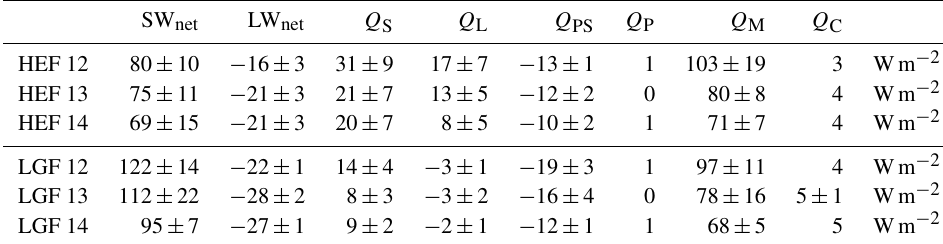
Table 4. The energy balance components are averaged over all stake locations. The uncertainty is given in respect to the minimum and maximum of the ensemble. The short-wave radiation (SW net ) has the largest impact, decreasing in importance from 2012 to 2014, with a less negative mass balance ( Q M ). The penetrating short-wave radiation ( Q PS ) follows the same pattern with the opposite effect. The long-wave budget (LW net ) is lower for LGF. The turbulent fluxes are greatest in 2012 and larger on HEF. The precipitation ( Q P ) and convective ( Q C ) heat flux are of minor importance. SW net LW net Q